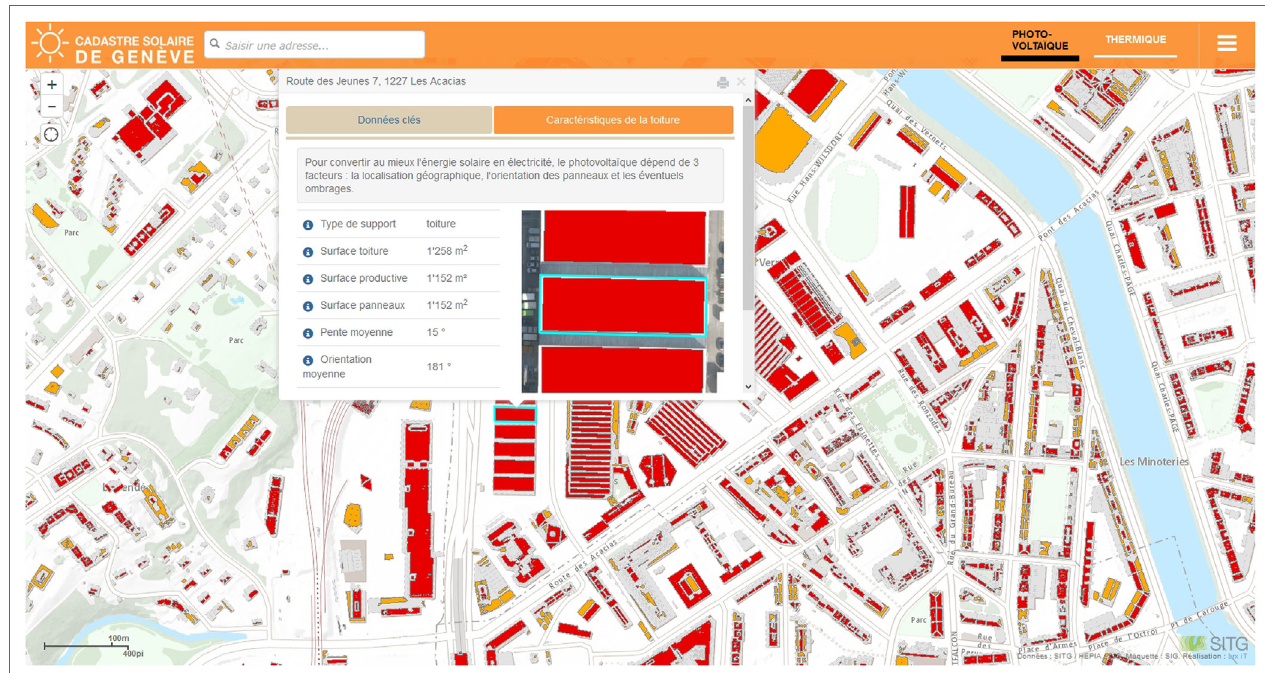
FIGURe 8 | Web-based tool developped by arx it under mandate of SITG; example of display for main rooftop characteristics. Reproduced from SITG—https:// sitg-lab.ch/solaire (2017). No permission is required from the copyright holder for the use of this image in this